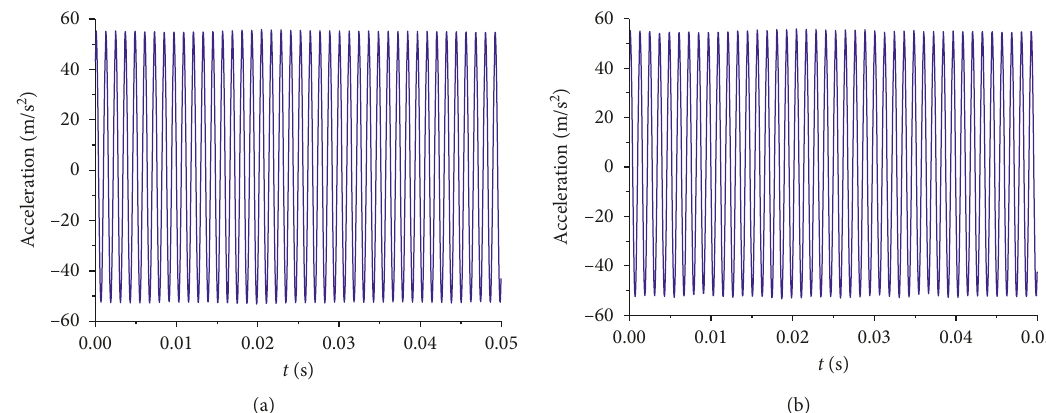
Figure 12: Time domain diagram of vertical vibration acceleration of wheelset: (a) health gear (b) the crack length of the pinion is 4mm.